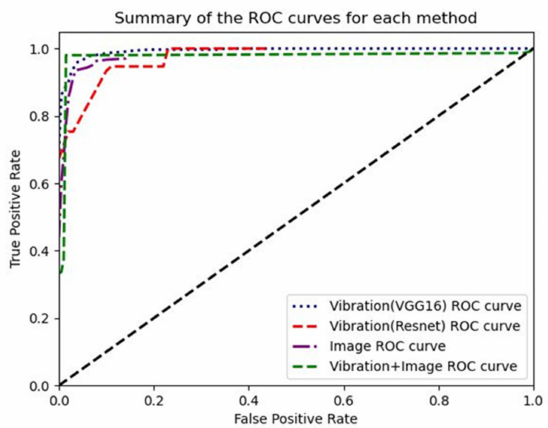
Figure 12. State identification ROC curves for validation set